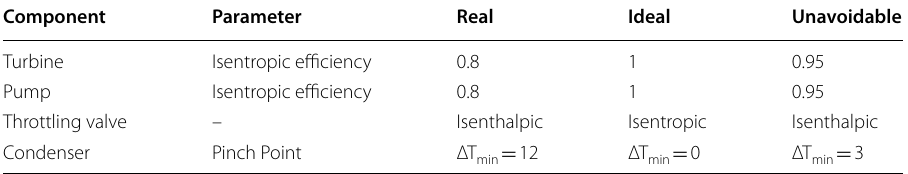
Table 3 Assumptions intended for real, ideal and unavoidable system conditions (Fallah et al. 2016; Gökgedik et al. 2016)